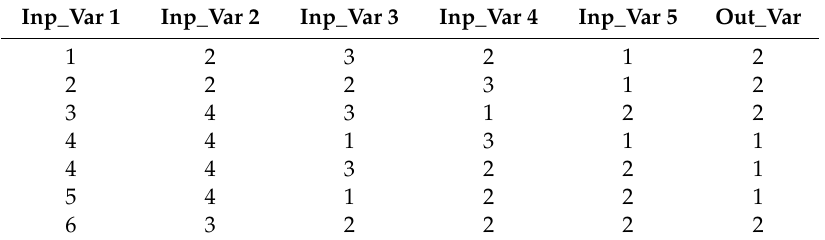
Table 8. Example of some values obtained from a unique table for the caesarean dataset. Inp_Var 1 Inp_Var